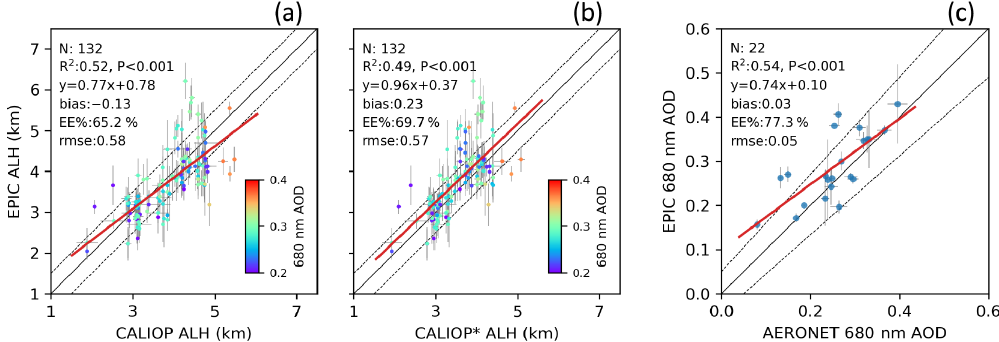
Figure 10. Comparison of EPIC ALH and AOD with the corresponding CALIOP and AERONET measurements. (a) Scatterplot of EPIC ALH versus CALIOP ALH by including all EPIC–CALIOP pairs shown in Fig. 9. The color of each scatter point represents the EPIC 680nm AOD value for the same EPIC pixels. (b) Same as panel (a) but for CALIOP ALH calculated with a background aerosol profile imposed for undetected aerosol layers. (c) Scatterplot of EPIC 680nm AOD versus AERONET 675nm AOD, collocated at the nine AERONET sites listed in Table 3. The dotted lines in both the scatterplots represent error envelops, i.e., ± 0 . 5km for ALH and ± ( 0 . 05 + 10% ) for AOD. Also annotated are the one-to-one line (solid black line), linear regression fit (red line), number of scatter points ( N ), coefficient of determination ( R 2 ), significance level ( P ), linear regression equation, bias, percentage of scatter points within the error envelop (EE%), and root mean square error